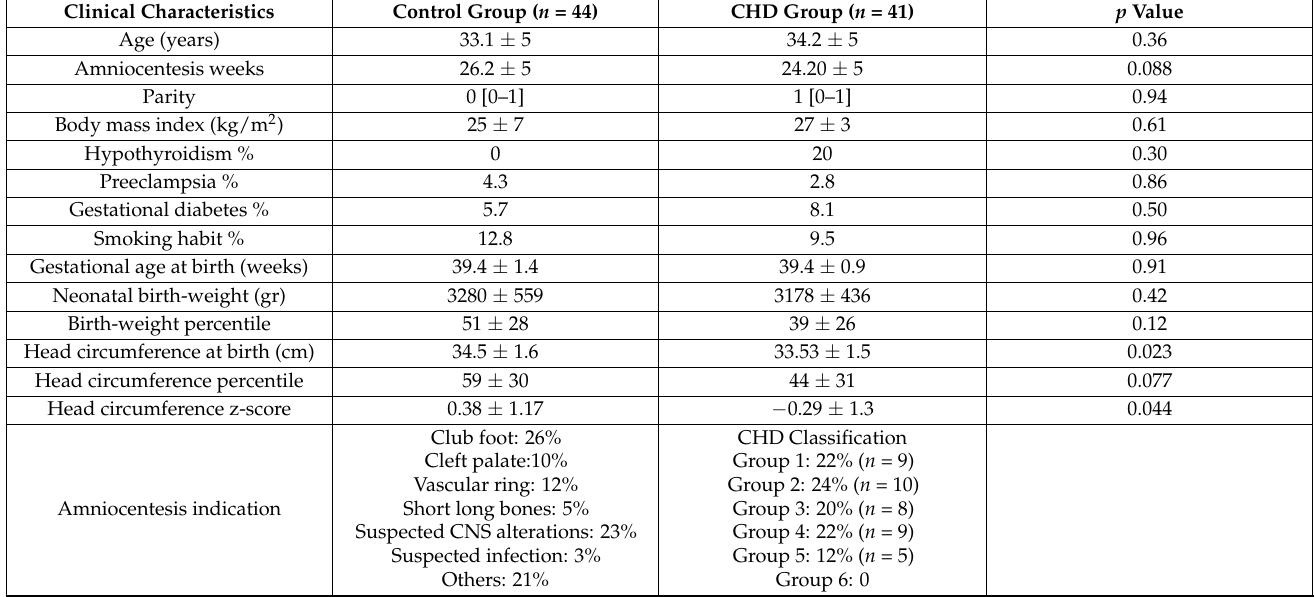
Table 1. Baseline and perinatal characteristics of the study population.